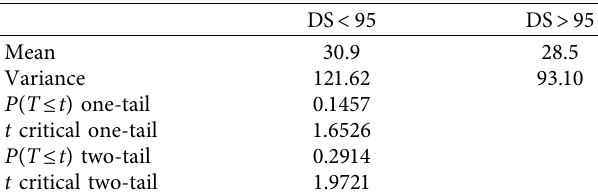
Figure 3: Age distribution of male drivers with DS under 95km/h.